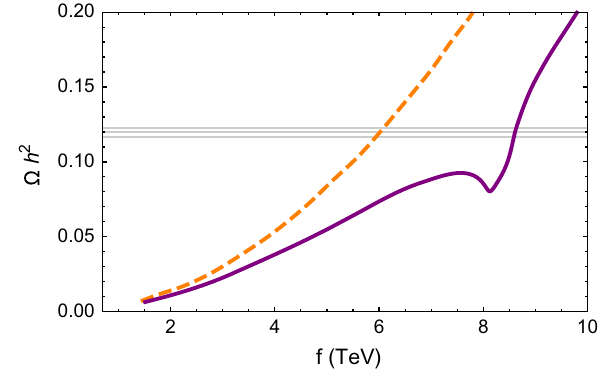
Fig. 1 Thedependenceoftherelicabundance (cid:23) h 2 of η asafunctionof thecompositenessscale f ,with( continuous )andwithout( dashed )non- perturbative effects; see [35]. The horizontal lines show the measured central value and a 95% C.L. interval around it as determined by Planck